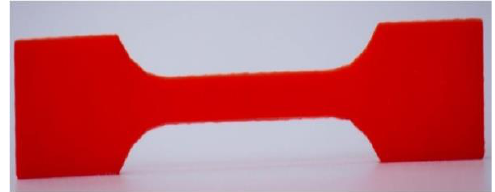
Figure 2. Test Specimen — ASTM D638.